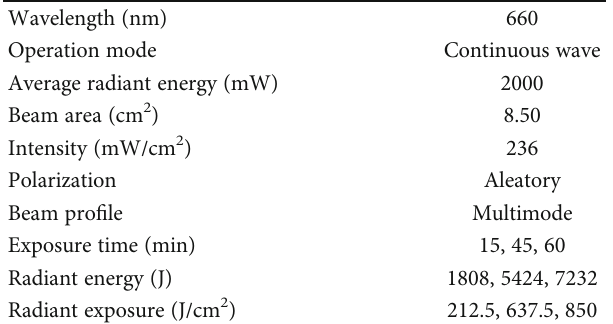
Figure 3: (a) Setup of the irradiation system with the LED; (b) lungs being irradiated with the Table 1: Spectroscopic parameters used to irradiate the lungs with Table 2: Values of positive end-expiratory pressure (PEEP) and the LED. lung volumes of the control group and protoporphyrin IX group (GPpIX).